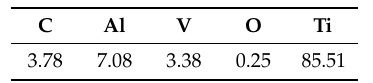
Table 1. Chemical composition (wt. %) of as-received Ti6Al4V alloy. Table 2. Tensile properties and hardness of as-received Ti6Al4V alloy.